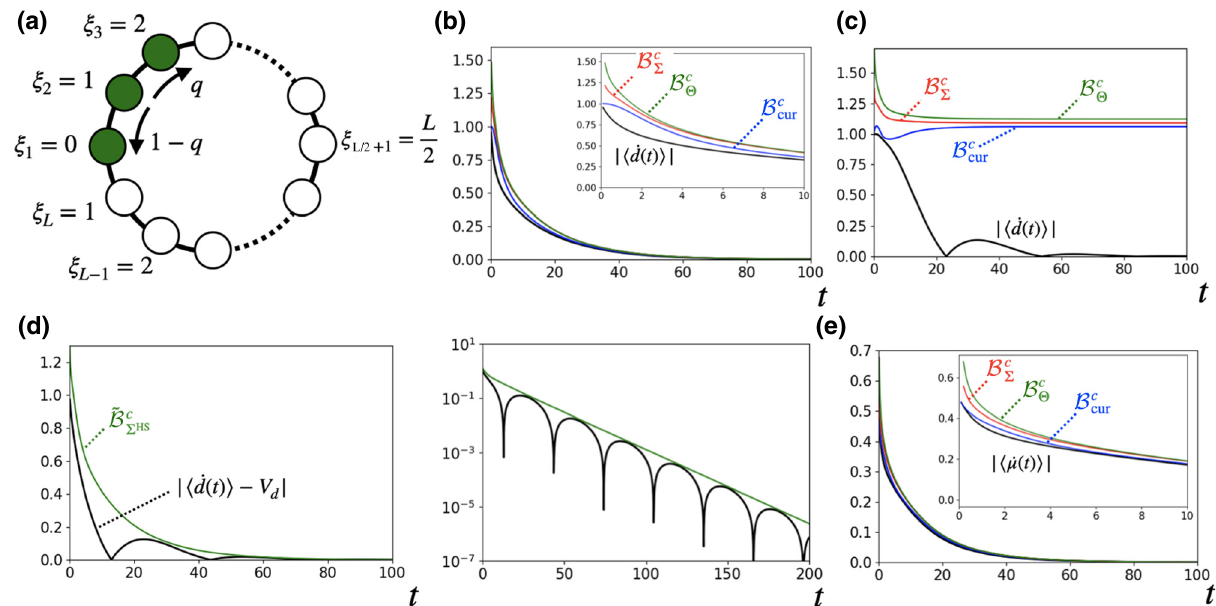
FIG. 11. (a) Schematic illustration for our model, which describes the symmetric and asymmetric hopping models. We consider L sites and M particles ( M = 3 is shown), which hop between neighboring sites at right and left with rates q and 1 − q , respectively. We |(cid:3)˙ consider the distance ξ l of particles from the first site in Eq. (119). (b) Speed of the sum of ξ l , d ( t ) (cid:4)| (black), and the speed limits for the symmetric simple exclusion process ( q = 0.5). The main and inset panels show results for the long and short times, respectively. (blue), which is further bounded by the entropic bound B c (cid:16) (red) and the bound The speed is well bounded by the current bound B c cur |(cid:3)˙ B c works well for short times, d ( t ) (cid:4)| for the asymmetric simple exclusion process ( q = 0.7). While B c (cid:17) (green). (c) Speed limits of cur |(cid:3)˙ none of the bounds become tight for long times due to the stationary current. (d) Modified speed limit of d ( t ) (cid:4) − V d | (black) for the ˜ B c asymmetric simple exclusion process ( q = 0.7). We find that the bound (green) is useful to evaluate the speed of the transition (cid:16) HS both for (left) short and (right) long times. (e) Speed of the maximum distance, |(cid:3) ˙ μ( t ) (cid:4)| (black), and the speed limits for the symmetric simple exclusion process ( q = 0.5). The main and inset panels show results for the long and short times, respectively. As seen from (blue), B c (cid:16) (red), and B c (cid:17) (green), which are obtained the almost collapse of the curves, the speed is tightly bounded by the bounds B c cur from the coarse-grained variables. We use L = 18 and M = 3 for all the